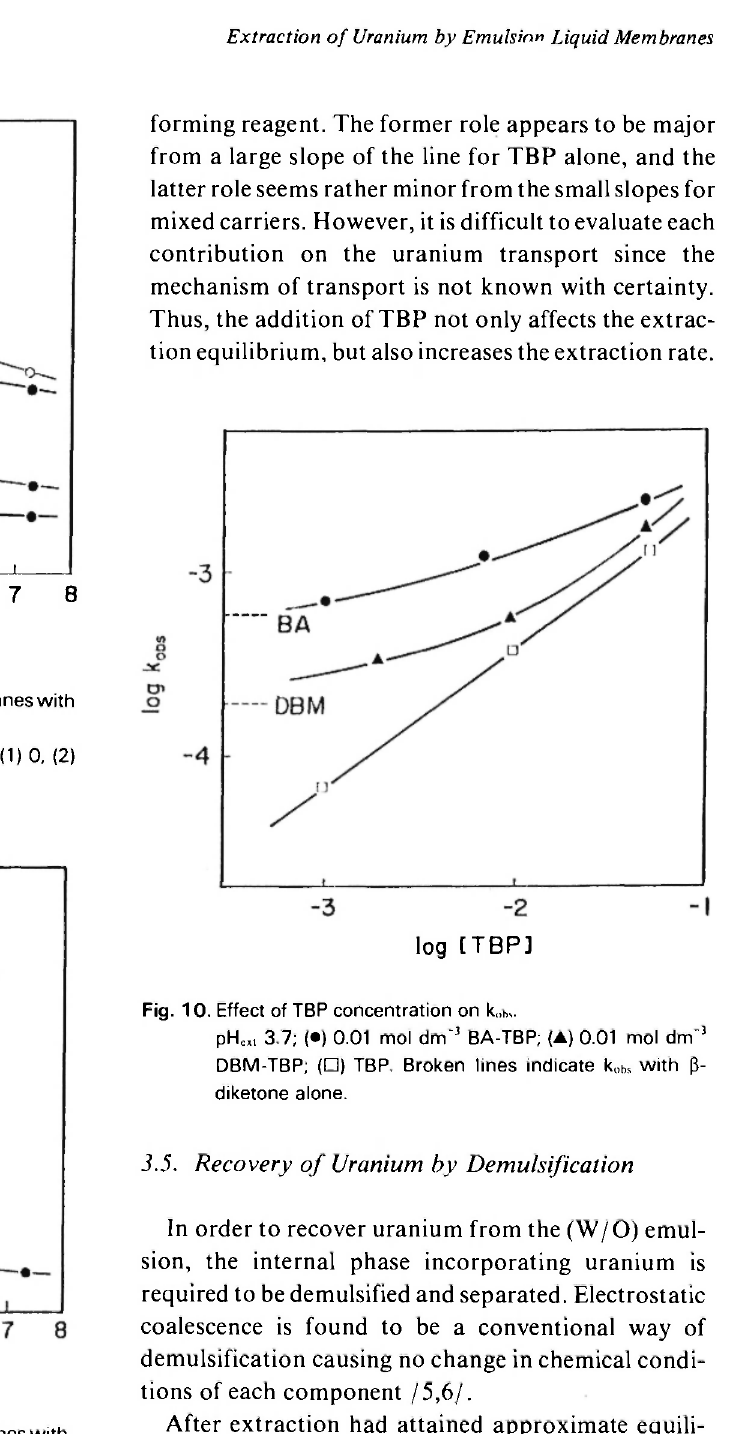
Fig. 9: Extraction of uranium by emulsion liquid membranes with DBM and TBP.